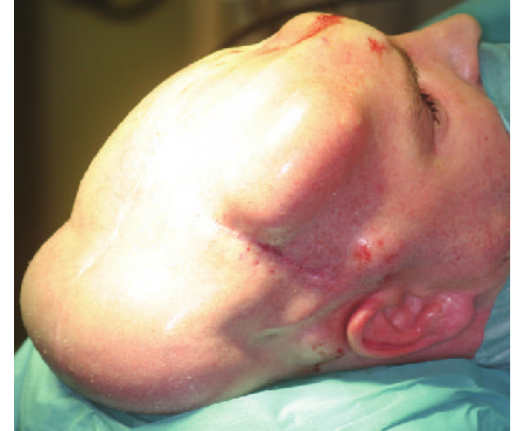
Figure 3: Prereconstruction photograph. Due to the expected skin loss, two inflatable skin expanders had been